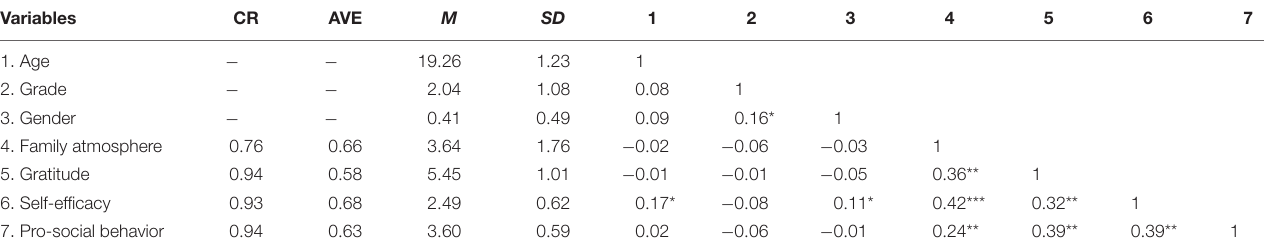
TABLE 1 | Descriptive statistics, correlations, composite reliability, and average variance extracted of the main variables. Variables